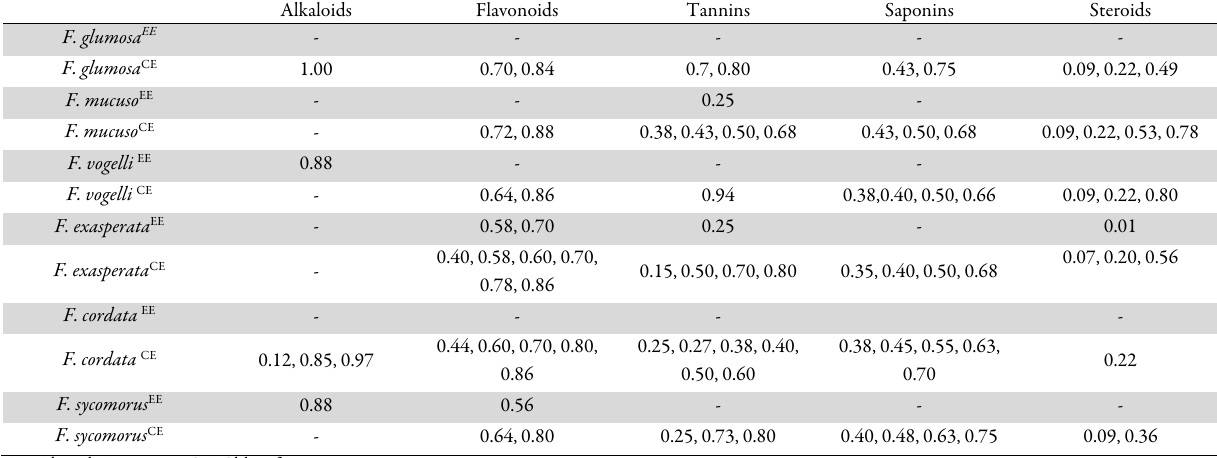
Table 3. Rf values of TLC solvent systems for leaf extract of different Ficus